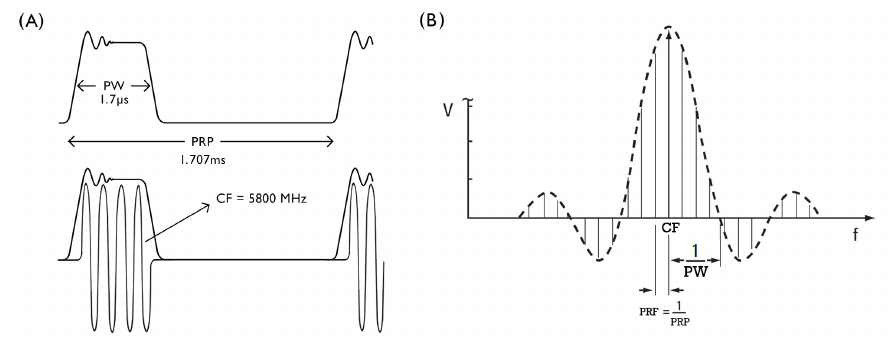
Figure 7. ( A ) Radar signal in time domain; ( B ) Radar signal spectrum. Adapted from